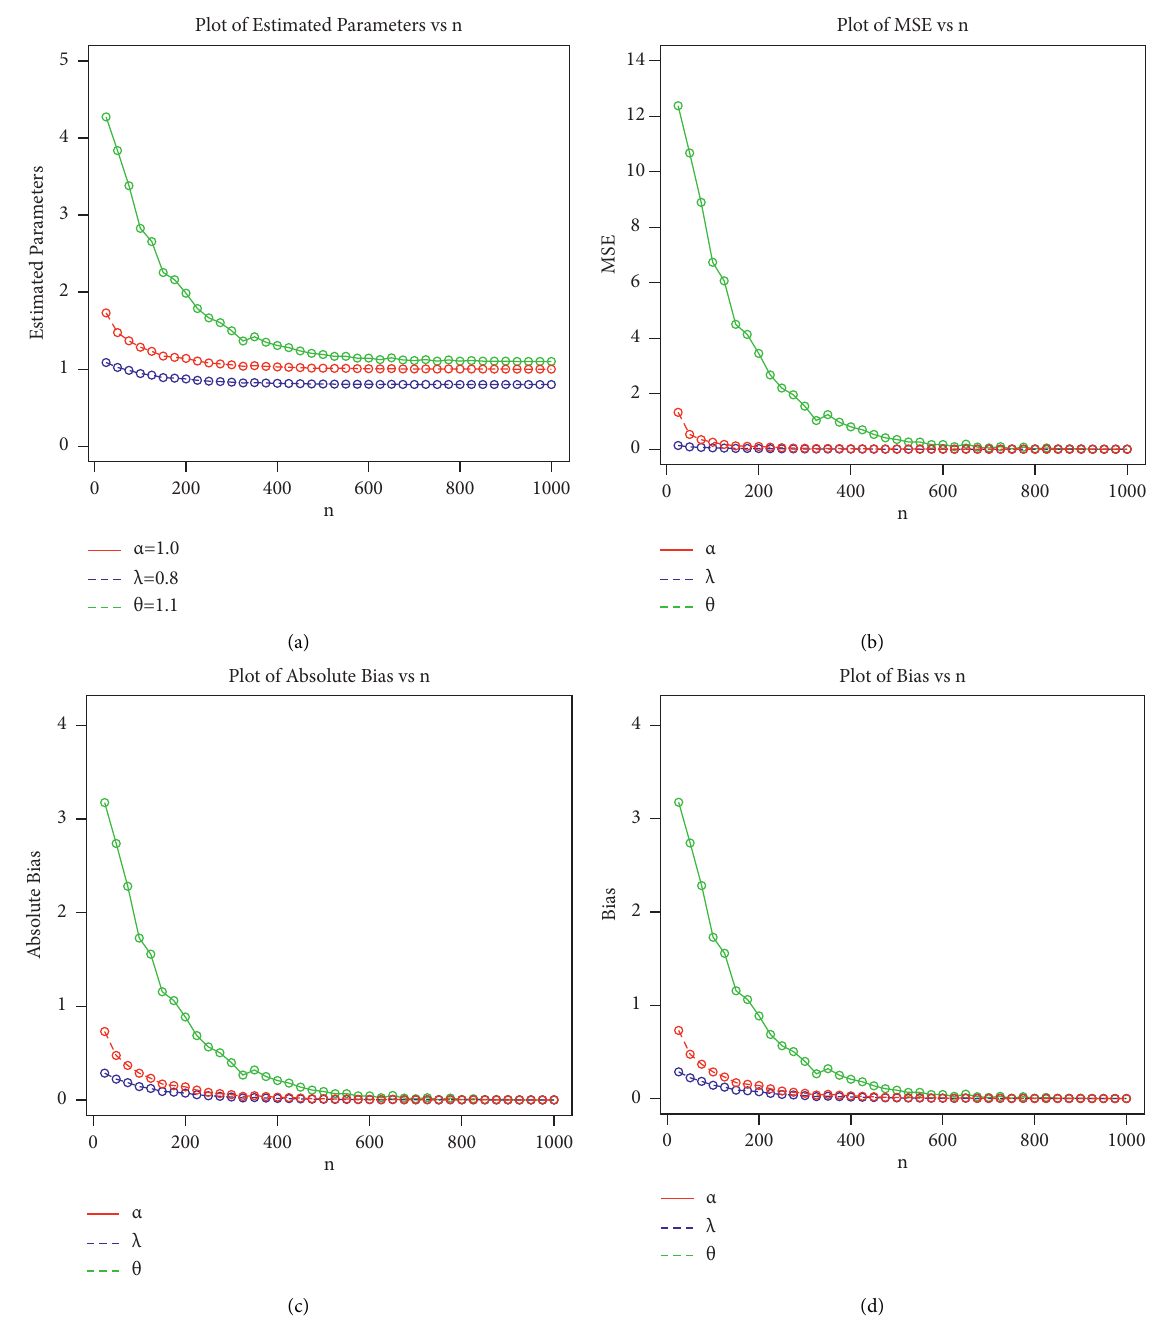
Figure 3: Different plots of the set-1 simulation results for the NEE-W